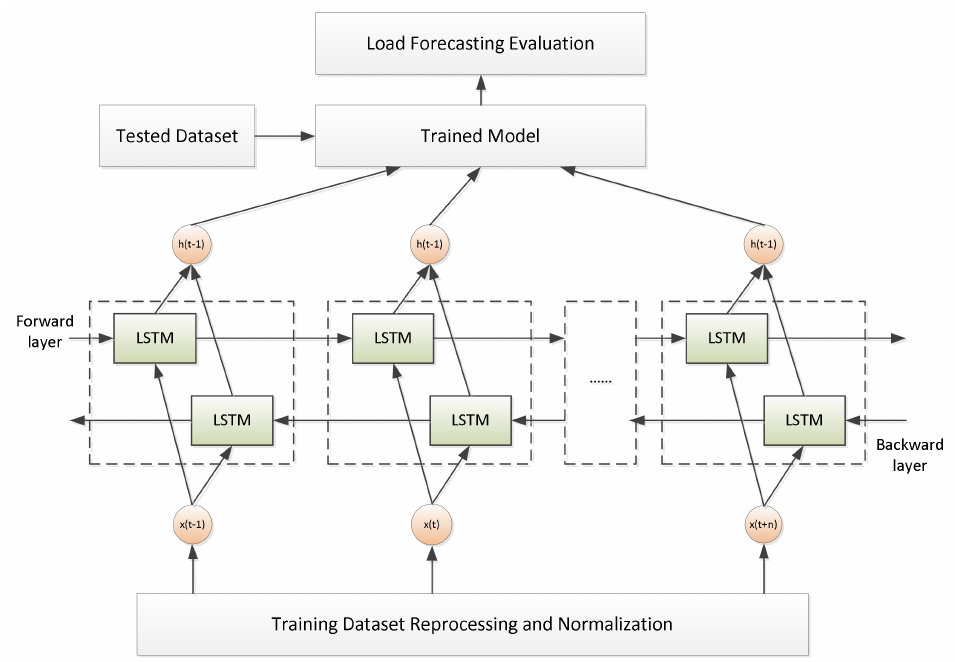
Figure 5. The framework of the proposed method for load